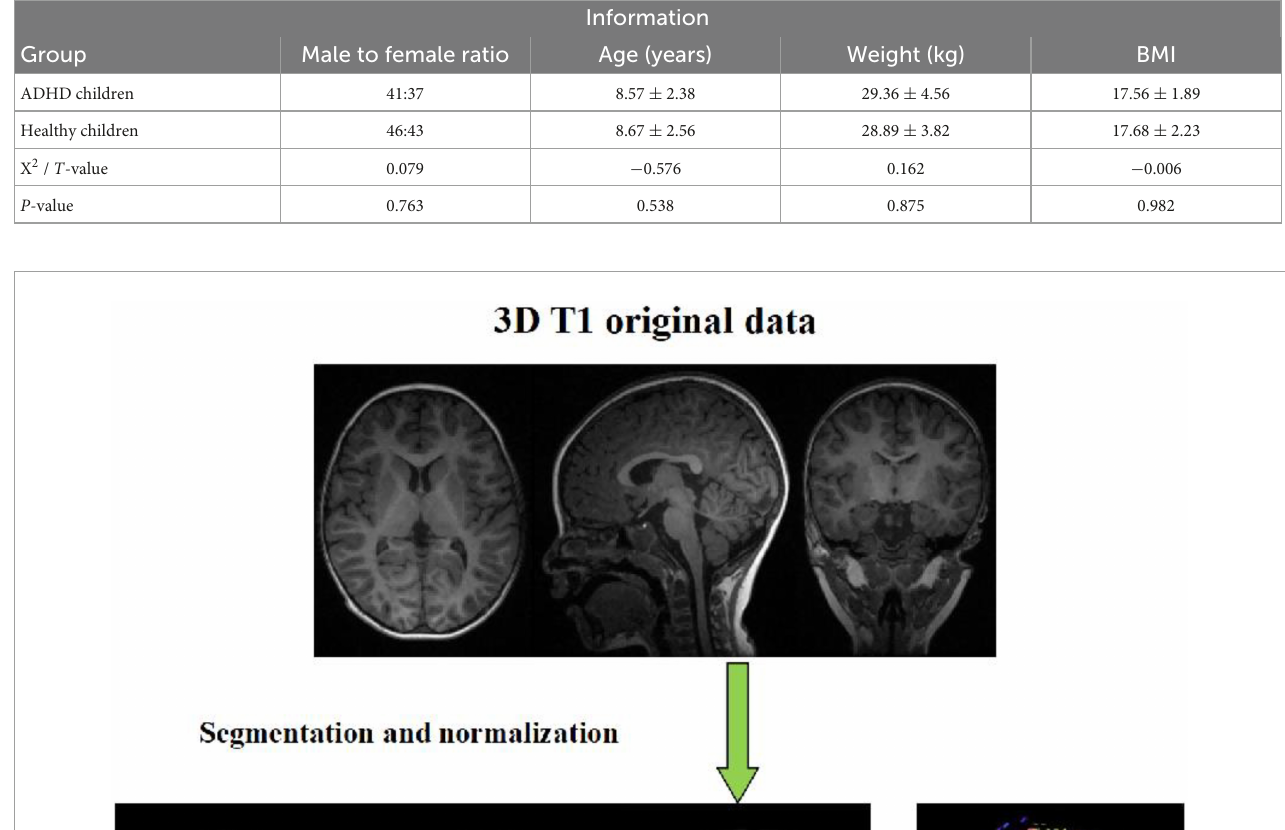
TABLE 1 Patient information.